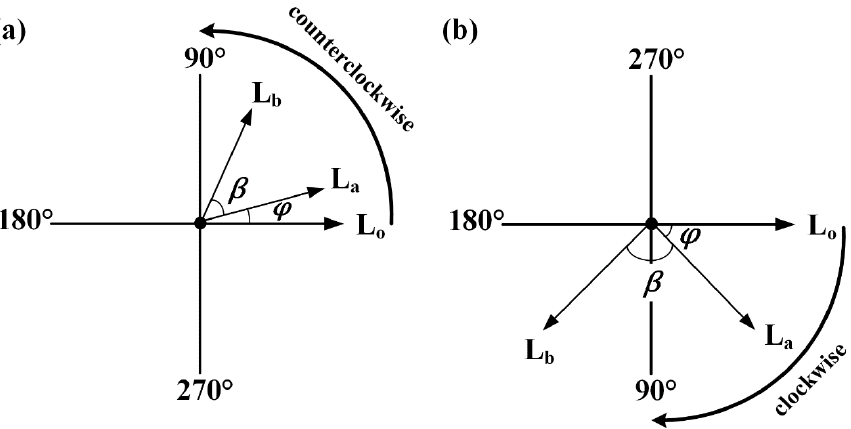
Figure 2. Polar coordinate systems for the counterclockwise and clockwise directional properties. ( a ) Standard and ( b ) reverse polar coordinate systems.